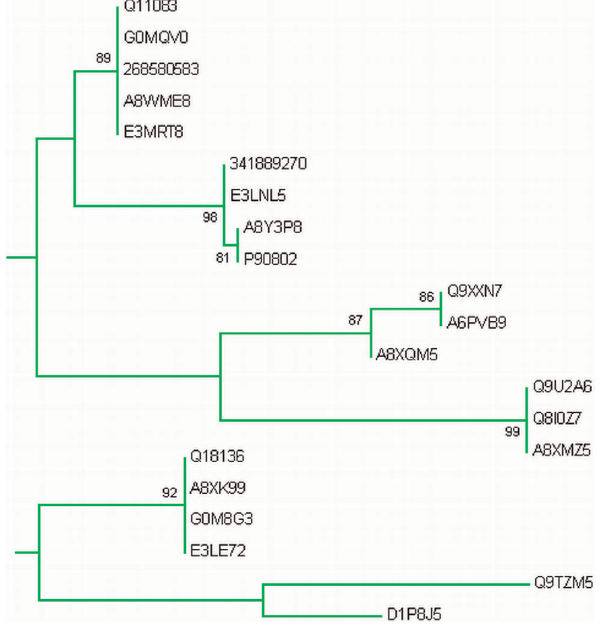
Figure 8. Group IV. Tree showing all proteins included in this group.